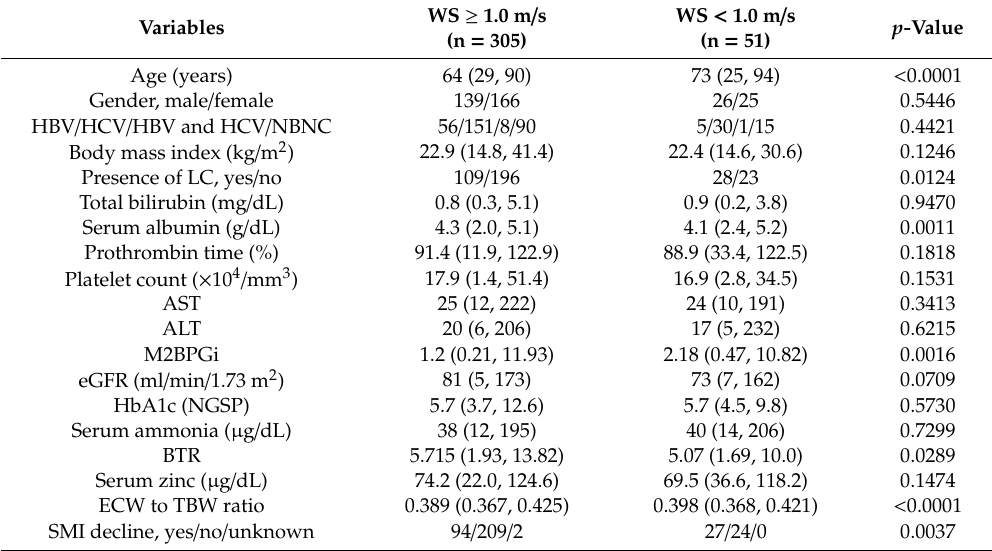
Table 5. Univariate analyses of factors linked to walking speed (WS) decline ( < 1.0 m /